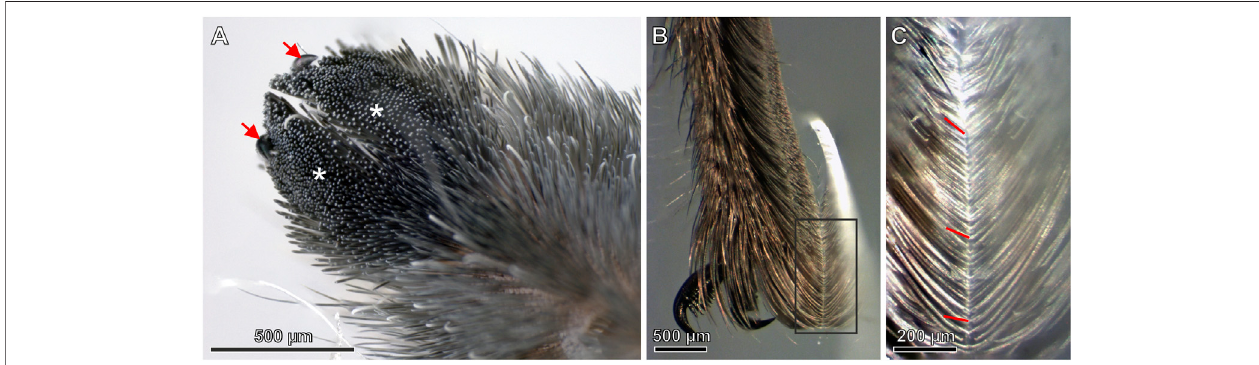
FIGURE1|(A) Ventralsurfaceofthetwo-lobedpretarsalscopulaclawtuft(blackish;asterisks)comprisingthetipsofthousandsofdenselyarrangedsetae.Arrows mark the claws (B) Side view of the pretarsal scopula in contact with a glass slide (C) Magni fi ed view of the rectangle marked in (B) . There is a notable increase of the angles of the seta tips with the glass surface from top (proximal) toward the bottom (distal) of the image caused by the increased curvature of the setae. Exemplarily, the lines indicate the angles of individual seta tips with the